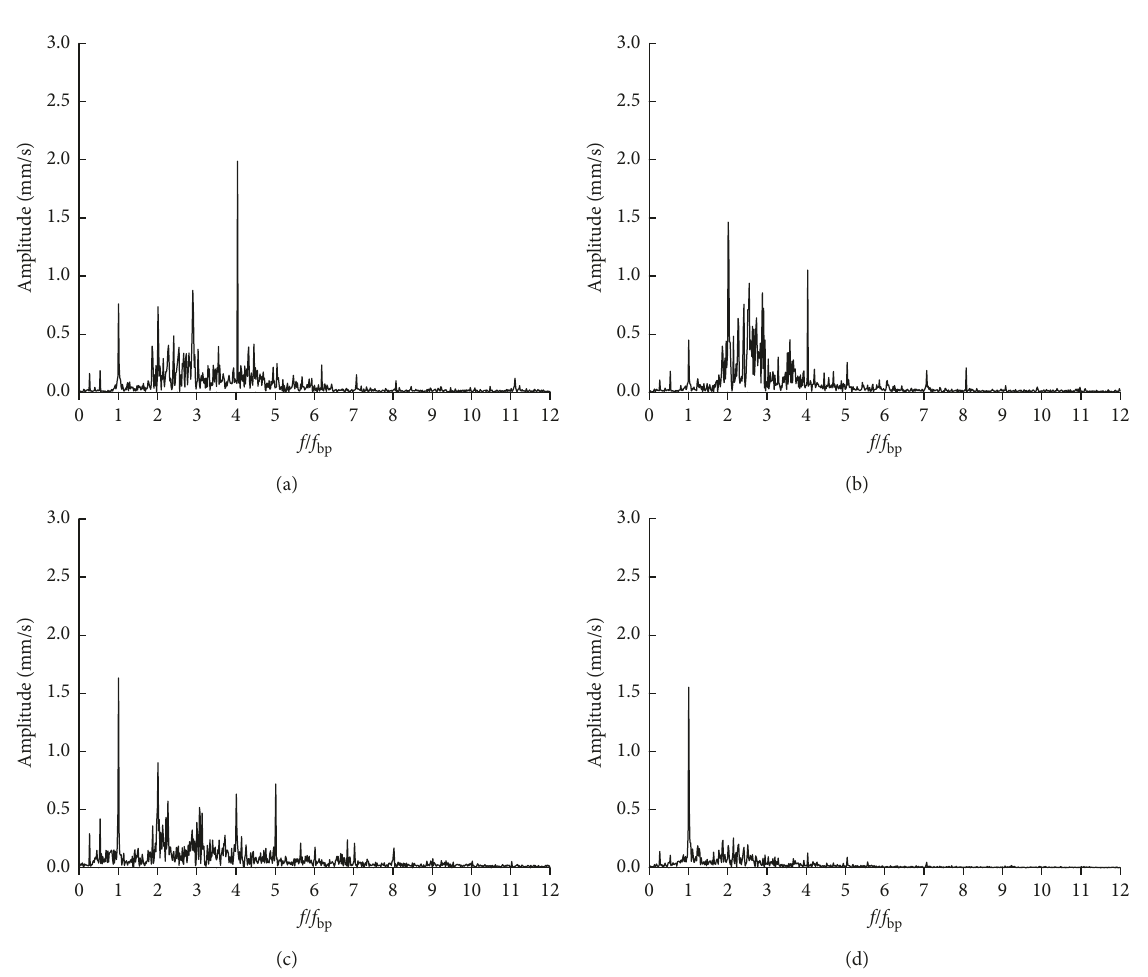
Figure 8: Vibration spectrum at 1.5 times the design flow rate: (a) CH3; (b) CH4; (c) CH5; (d)